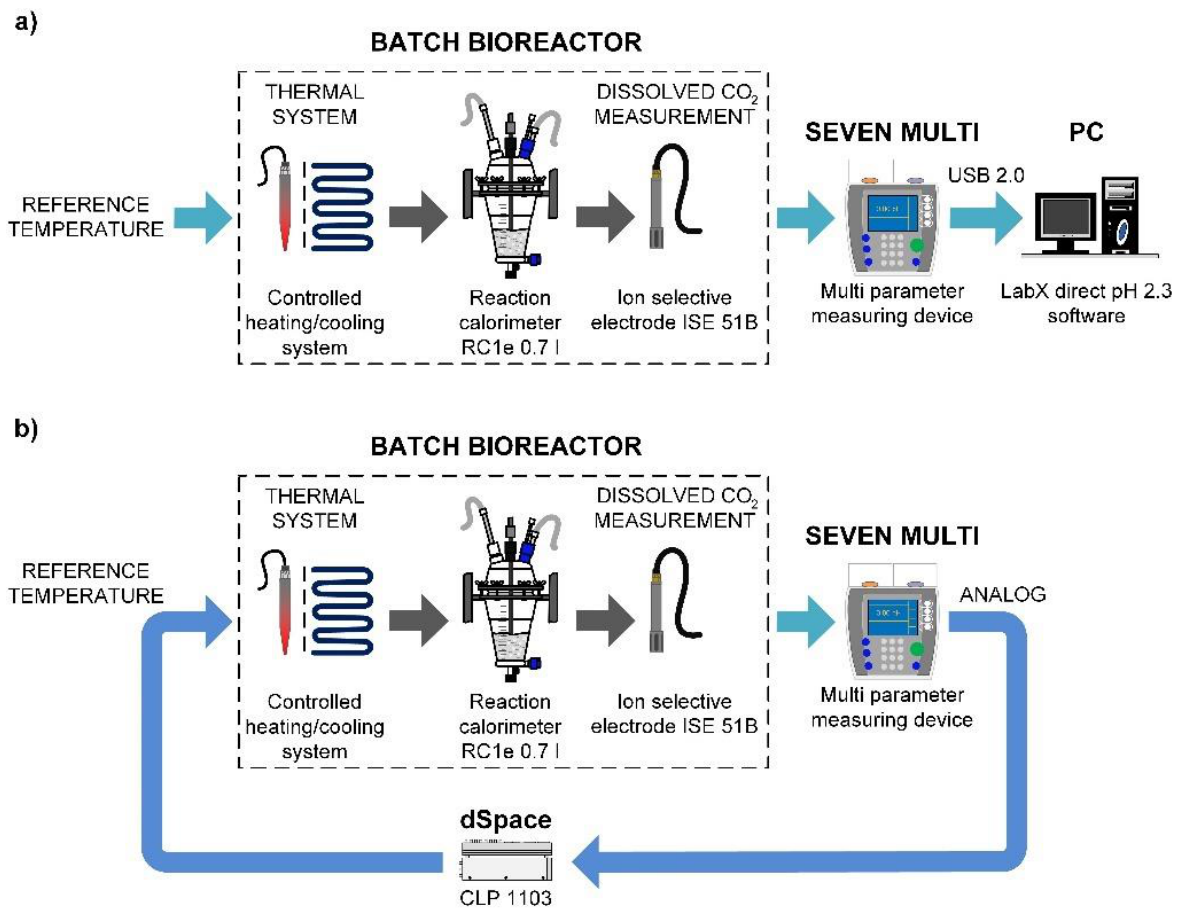
Figure 1. ( a ) Laboratory system for measurement of the time response of the dissolved CO 2 production on the temperature changes and estimation of model parameters. ( b ) Laboratory system for the control of dissolved CO 2 production.